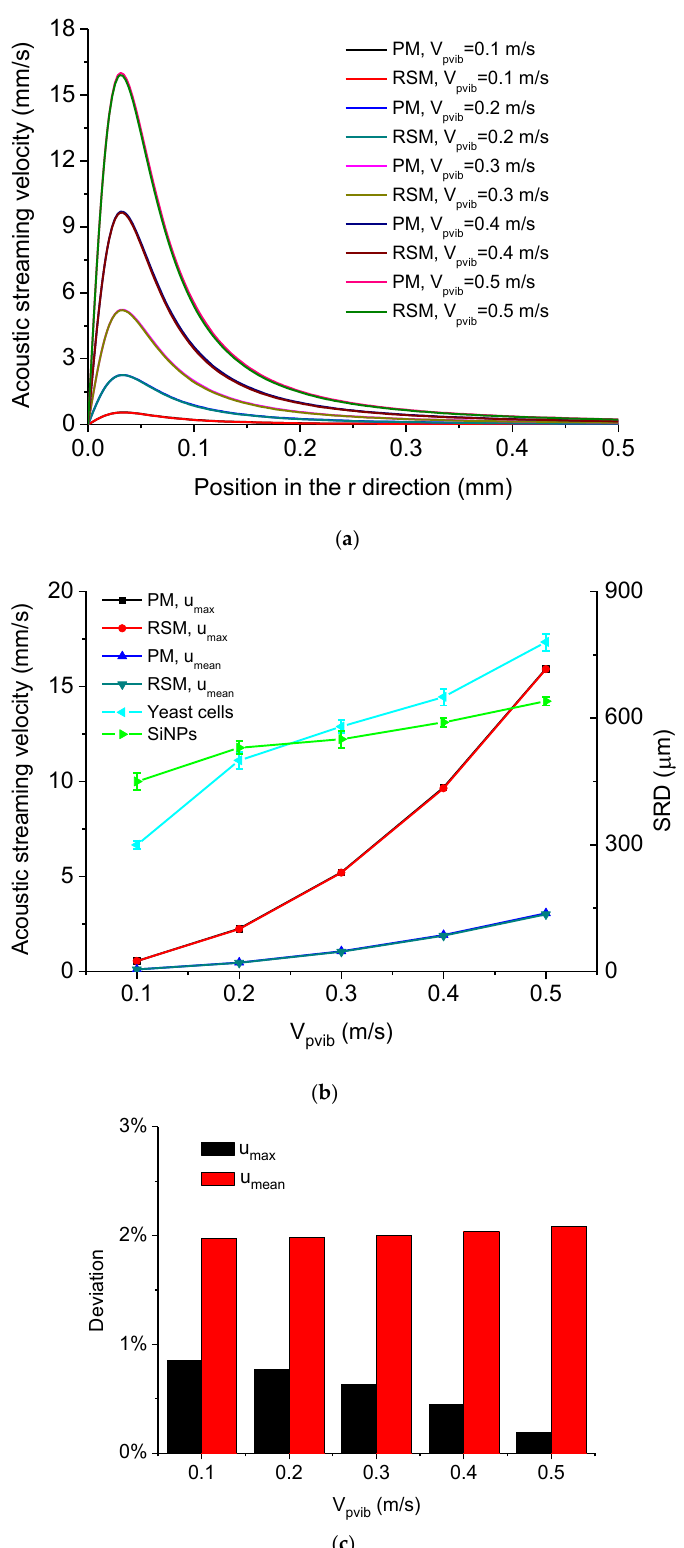
Figure 5. ( a ) Computed acoustic streaming velocity distribution along the r direction at the droplet-substrate interface in the ultrasonic probe-droplet-substrate system under different V pvib . ( b ) u max , u mean and SRD versus V pvib in the ultrasonic probe-droplet-substrate system. ( c ) Deviations of u max and u mean computed by the PM and RSM versus V pvib in the ultrasonic probe-droplet-substrate system. The dependency of acoustic streaming velocity on the driving frequency of the system f p is